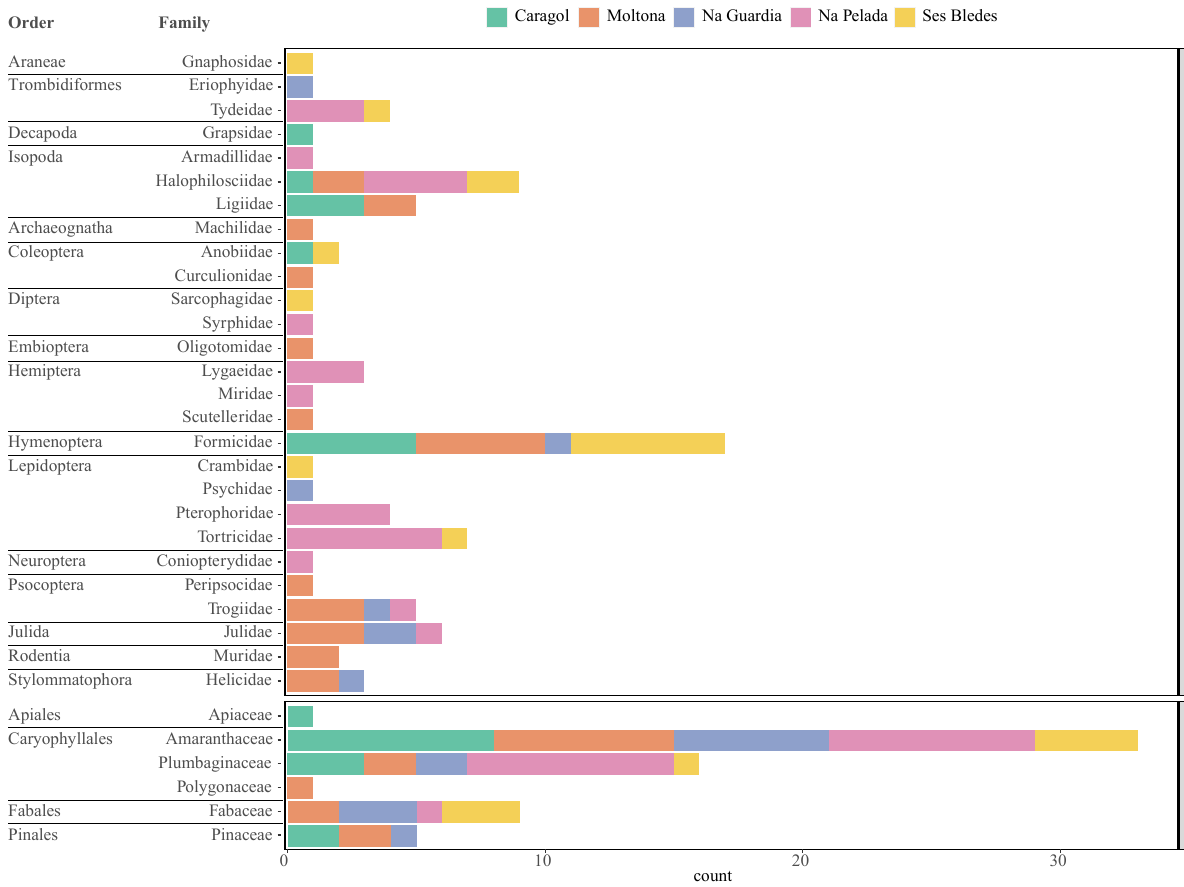
Figure 2 . Frequencies of occurrence of each order of animals in the diet composition of Podarcis lilfordi through morphological and molecular analysis.